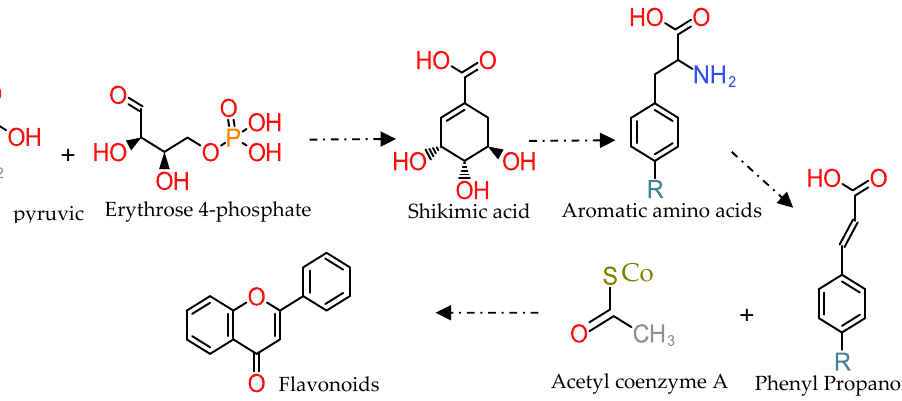
Figure 1. Flavonoid biosynthesis pathways (general structure of flavonoids).